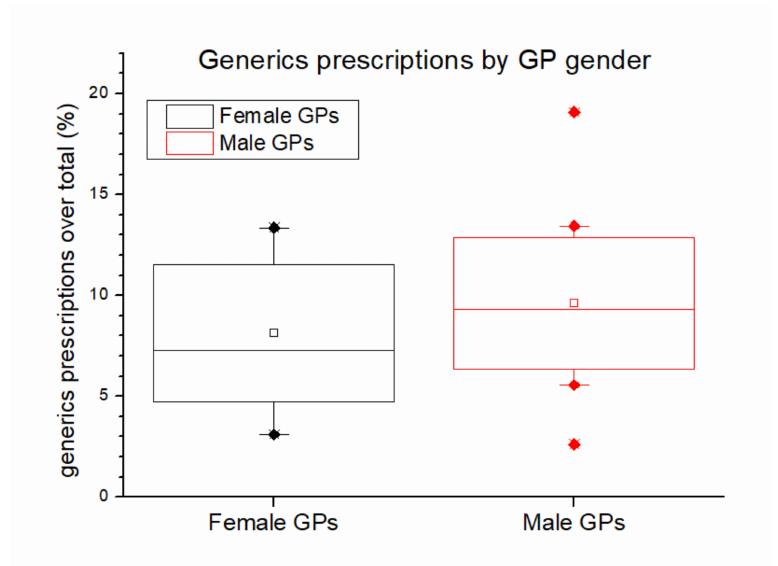
Figure 5. Boxplot of GPs generics prescriptions by GPs gender.